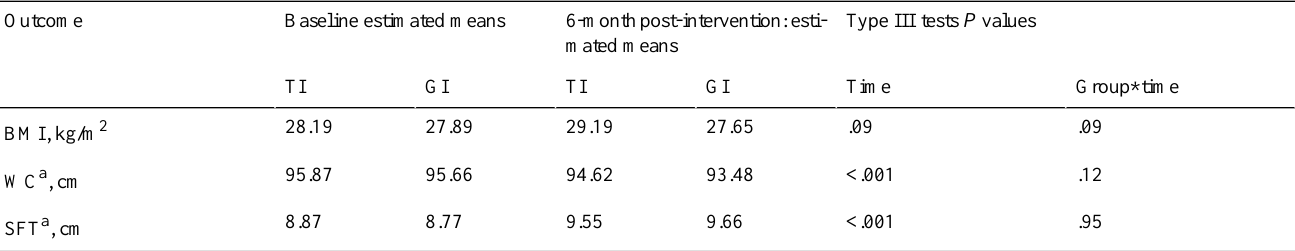
Table 3. Results of general linear mixed model analyses for objectively measured anthropometric outcome measures: Estimated marginal means and P values of time and group*time effects (N=480).